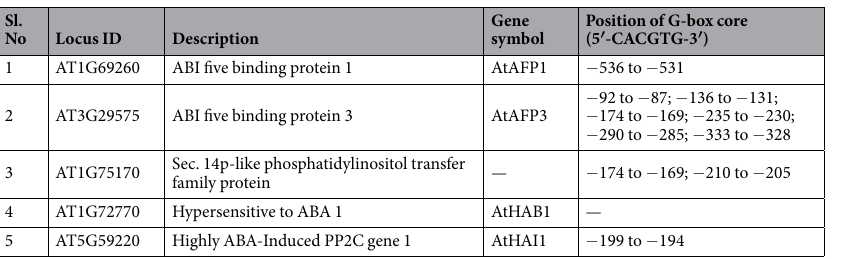
comprehensive meta-analysis for the effects of drought stress on photosynthesis and related molecular and meta- bolic events has identified four members of the bZIP (basic leucine zipper domain) family proteins that includes GBF3 39 . In addition, stress-induced expression of GBF3 correlated with Sucrose synthase 3 and Neutral invertase which are involved in grain filling 39 . Abiotic stress response of AtAFP1 , AtAFP3 and AtHAI1 which are potentially regulated by AtGBF3 has been shown through ABA signaling pathway (Supplementary Fig. S16) 40, 41 . The AFPs (ABI five binding proteins) are highly conserved plant-specific proteins that regulate ABA and stress response